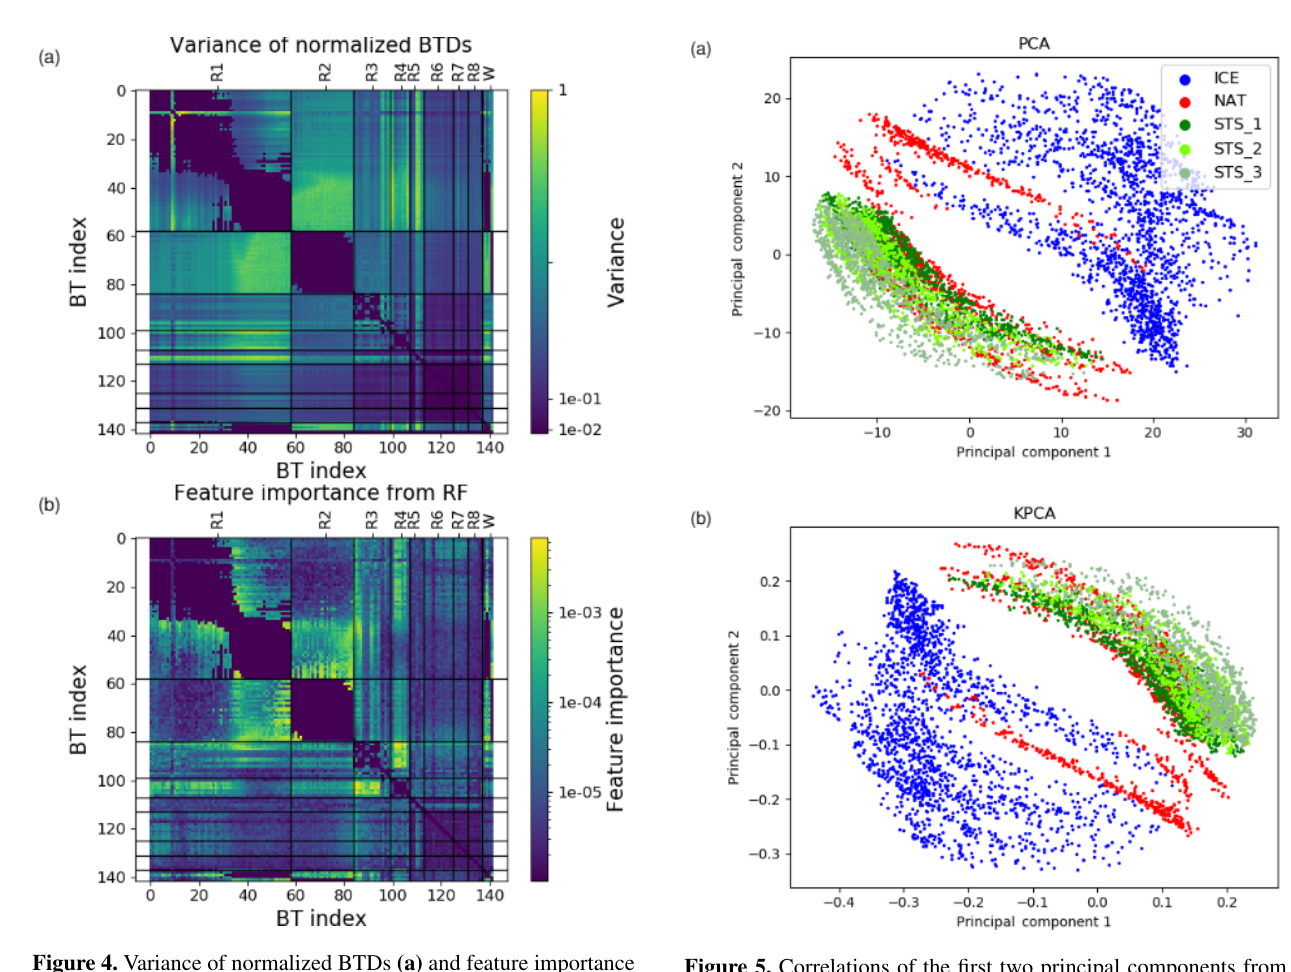
Figure 5. Correlations of the first two principal components from the PCA (a) and KPCA (b) analysis applied to the